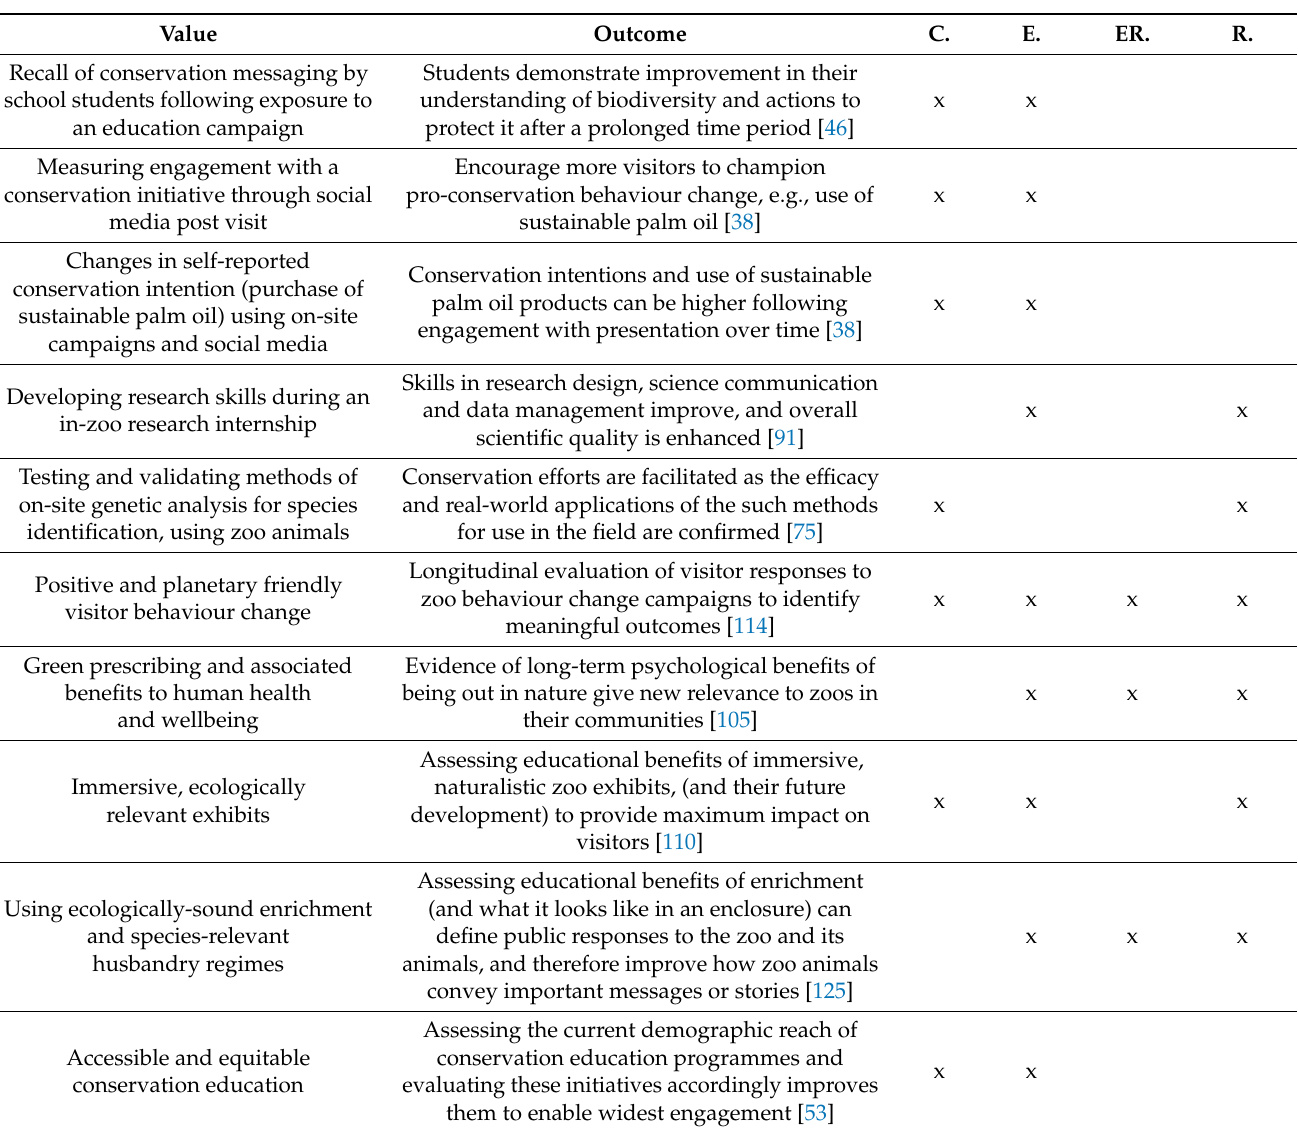
Table 1. Examples of measurements of social value and their outcome within the zoo, based around the different aims of the modern zoo. C.= Conservation; E.= Education; ER. = Engagement/Recreation; R. = Research. Outcome C. E. ER.